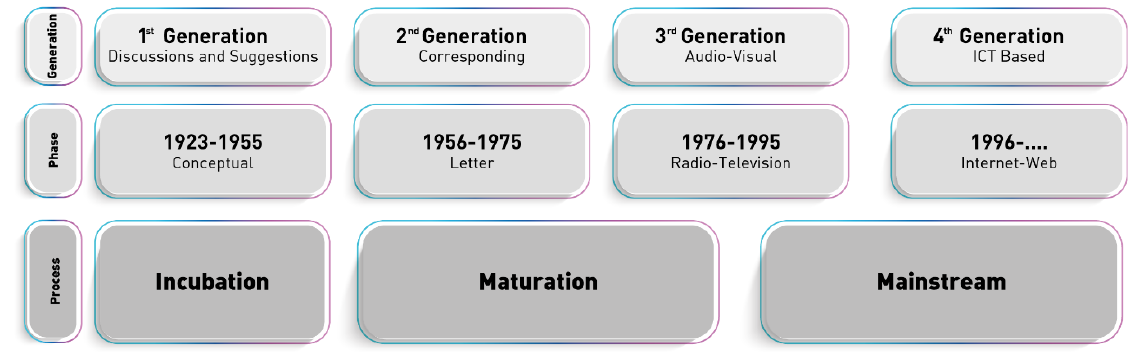
Figure 1. Generations of ODL in Turkey, adapted from “The Past, Present and Future of the Distance Education in Turkey” by A. Bozkurt, 2017, Açık Öğretim Uygulamaları ve Araştırmaları Dergisi, 3, p. 88. CC